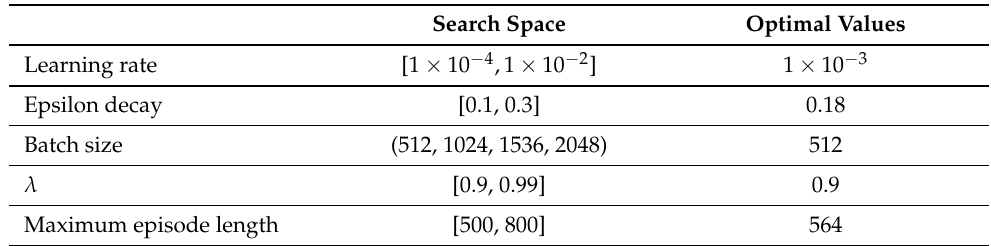
Table 5. Learning parameters